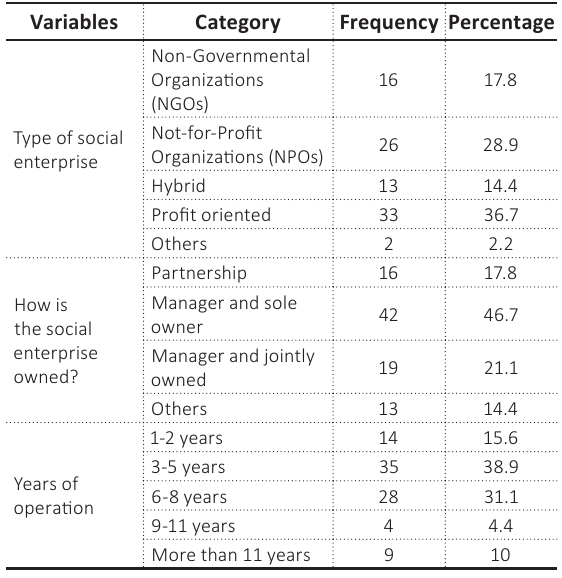
Table 2 (cont.). Demographic information of surveyed social